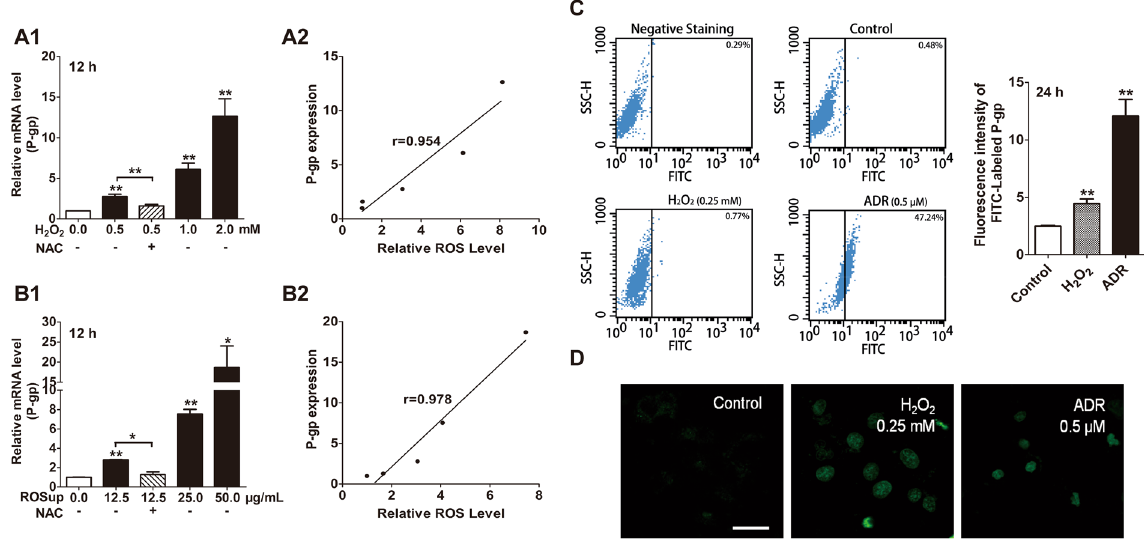
Figure 2. Effects of ROS agents on P-gp expression in MCF-7S cells. ( A ) H 2 O 2 increased P-gp mRNA expression, which could be reversed by NAC (10 mM, 30 min of pretreatment). ( B ) ROSup increased P-gp mRNA expression, which could be reversed by NAC (10 mM, 30 min of pretreatment). ( C ) H 2 O 2 (0.25 mM, 24 h) or ADR (0.5 μ M, 24 h) enhanced P-gp protein expression, as demonstrated via by flow cytometry analysis and quantified according to mean fluorescence intensity. ( D ) H 2 O 2 (0.25 mM, 24 h) or ADR (0.5 μ M, 24 h) enhanced P-gp protein expression, as shown with laser confocal scanning using an FITC-conjugated